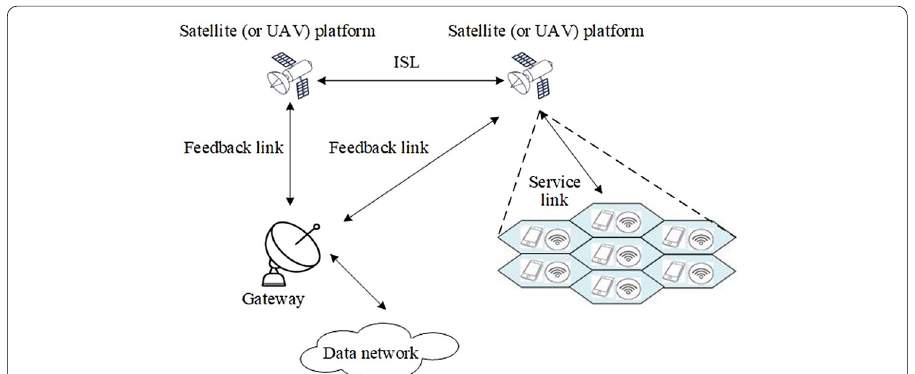
large number of drones and smart